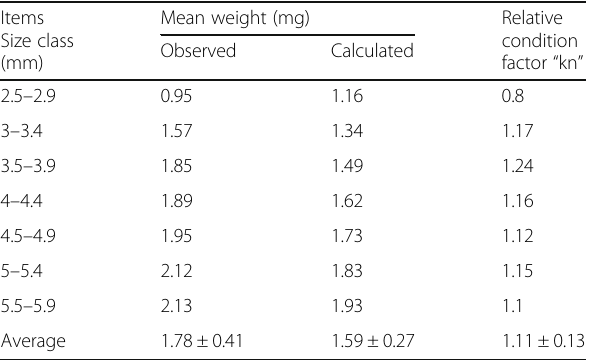
Table 1 The carapace width-body weight relationship and relative condition factor of H. marsupialis females from Gulf of Aqaba, Red Sea, Egypt